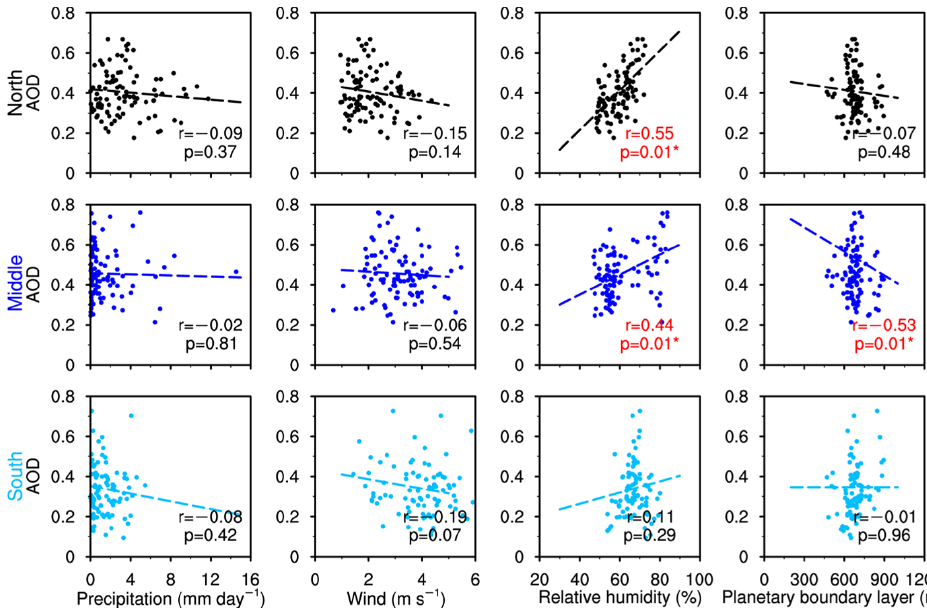
Figure 8. Relationships between daily mean AOD with precipitation, wind speed, radiative humidity and planetary boundary layer height over North, Central, and South India during the lockdown period. Correlation coefficients (r) are calculated via the orthogonal linear regression, and the statistical significance ( p ) is using the two-tailed Student’s t -test. Inhere, the statistical significance level at 95% ( p < 0.05) is marked with the asterisk (red color).